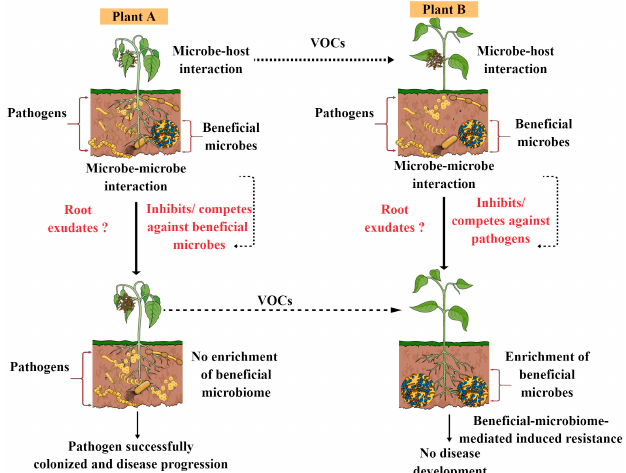
Figure 2. Schematic diagram showing how pathogen attack their hosts, either suppressing or enriching the beneficial microbiome and in turn leading to either disease resistance or disease progression. Susceptible plants may release VOCs, which can trigger immune activation and plant root exudation and can influence beneficial microbiome assembly, ultimately leading to disease resistance.